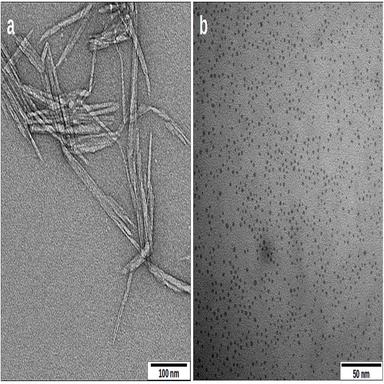
TEM images of the stained CNC (a) and CNC-Ag (b).